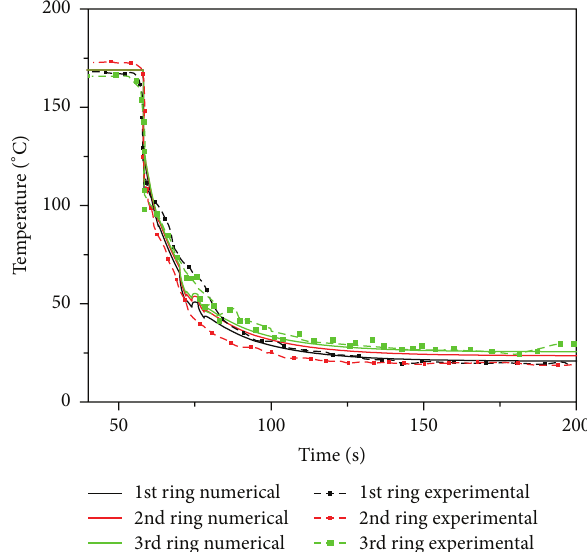
Figure 7: Benchmarking radial fuel surface temperature prediction of different